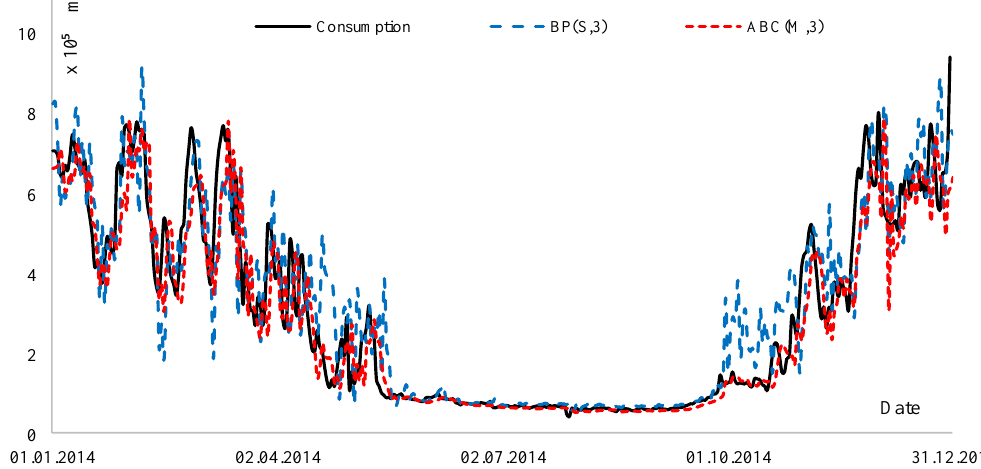
Figure 9. The best ANN structures of BP (backpropagation) and ABC day-ahead forecasts for test data.